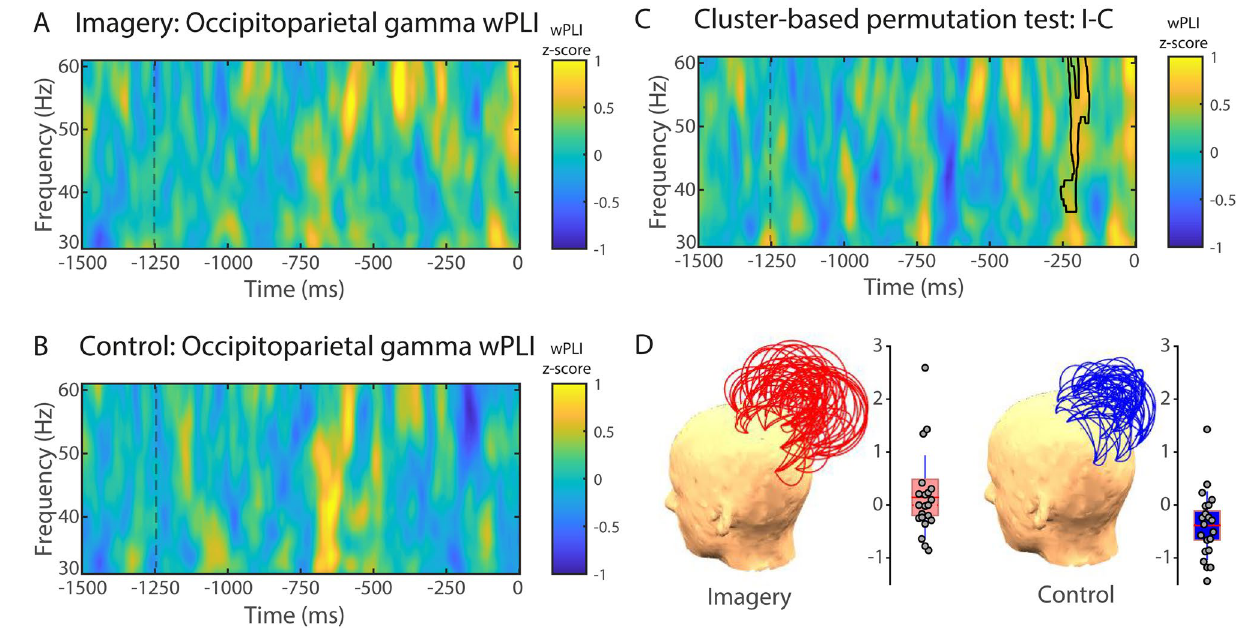
Figure 4. Gamma phase-synchrony between occipital and parietal electrodes. wPLI (30–60 Hz) for visual imagery ( A ) and control ( B ) conditions. ( C ) Cluster-based permutation test comparing visual imagery and control conditions. The area highlighted in the time–frequency chart depicts a significant wPLI cluster between conditions (visual imagery minus control) in the gamma band (30–60 Hz). ( D ) Region of interest (ROI) for phase-synchrony analysis. wPLI values are expressed in standard deviations (z-scores) in reference to the baseline (− 1500 to − 1250 ms). Trial length (− 1500 ms) is relative to response time (0 ms). ( D ) Topographical representation of occipitoparietal wPLI channel pairs and single-participant wPLI values for the imagery (left) and control (right) conditions. Each arc represents a pair of channels, and the height of the arc is its normalised value. Grey circles represent single-participant wPLI values for the cluster depicted in ( C ) for the imagery (left panel) and control (right panel) conditions. The red horizontal line represents the group mean, the rectangle represents SEM, and the red-dashed horizontal line represents the group